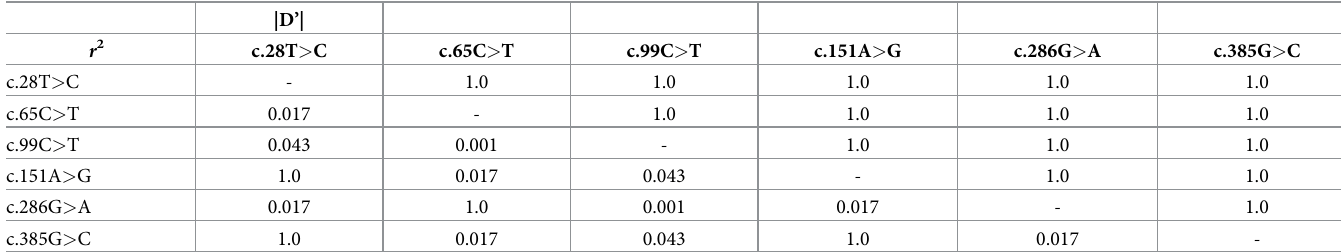
Table 2. Linkage disequilibrium (LD) among six single nucleotide polymorphisms (SNPs) of the PRND gene in Korean native black goats.